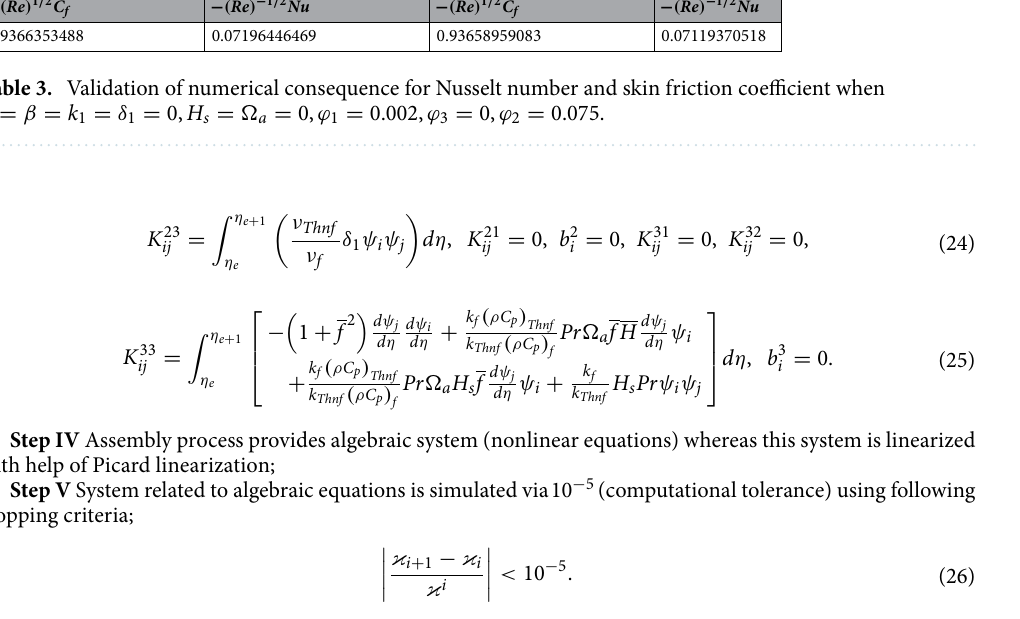
Nazir et al. 29 Present